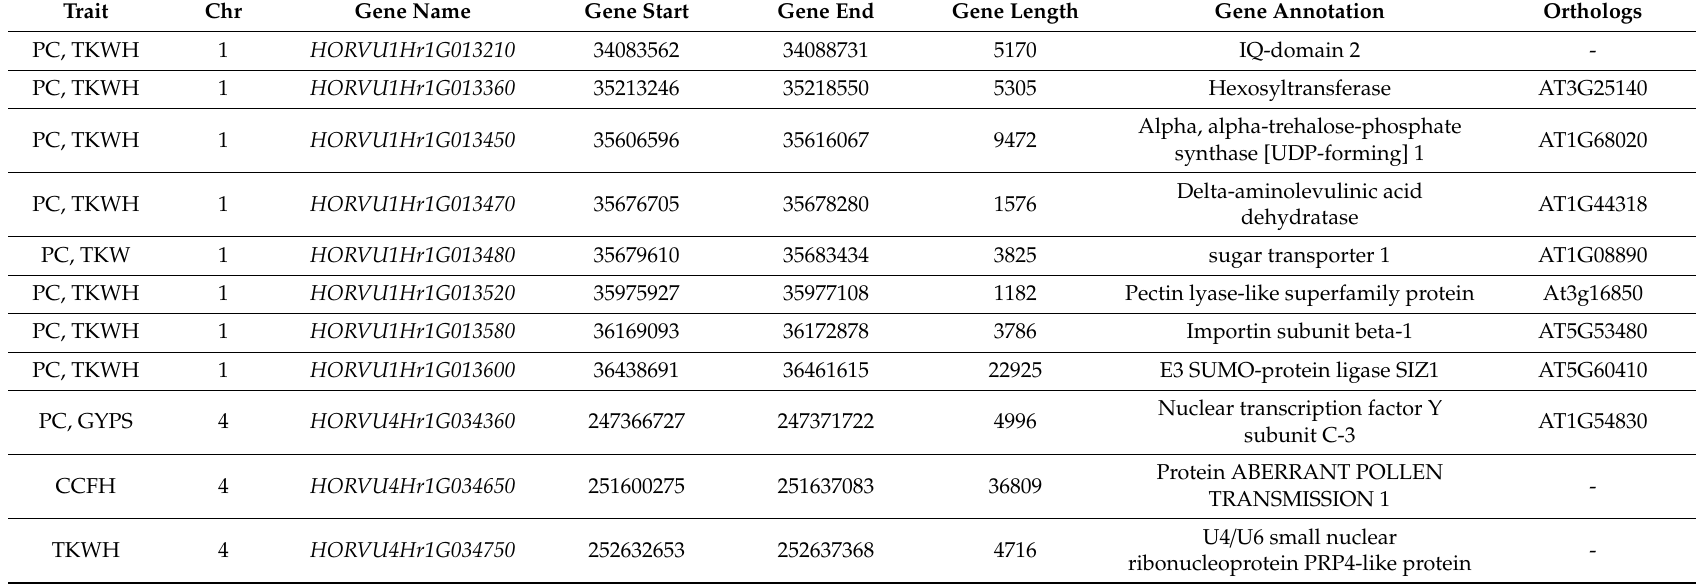
Table 4. Candidate genes associated with the variation of the traits in spring barley under control and heat during flowering and seed setting.